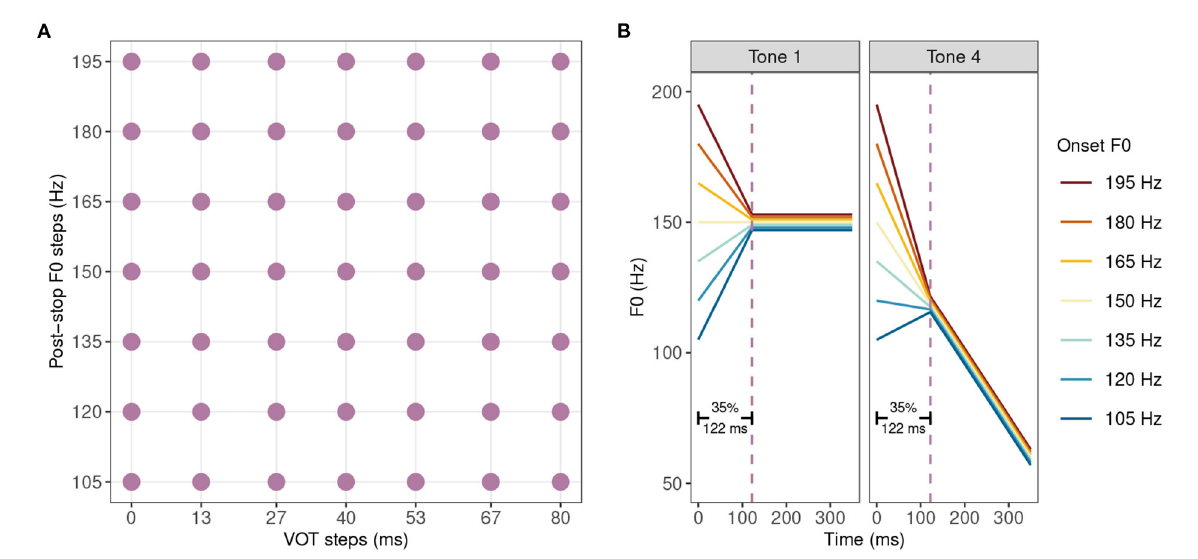
FIGURE5 Manipulation of target stimuli for all perception experiments. (A) Each dot represents one stimulus, with its x coordinate corresponding to the VOT of the initial labial stop, and its y coordinate to the initial F0 of the following vowel. (B) Illustration of F0 trajectory manipulation for target syllables. Note the vowel duration in actual stimuli is not necessarily 350 ms due to the trade-off between VOT and vowel duration, which was also manipulated. The invariant parts across different tokens (i.e., after 122 ms) are shifted vertically in the figure for visual clarity